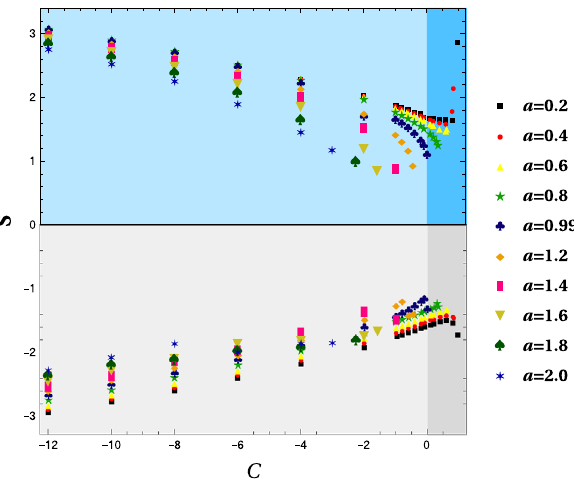
Fig. 7 Phase plot between the parameters S and C , shows the bound on the particle’s spin S for different set of values of parameters a and C . The permitted region is between the curves formed by the dots. Here, the blue and the grey regions represent corotating ( J z > 0) and counter-rotating ( J z < 0) cases of the spinning particle around rotating braneworld BH, respectively. The mass parameter M sets to unity